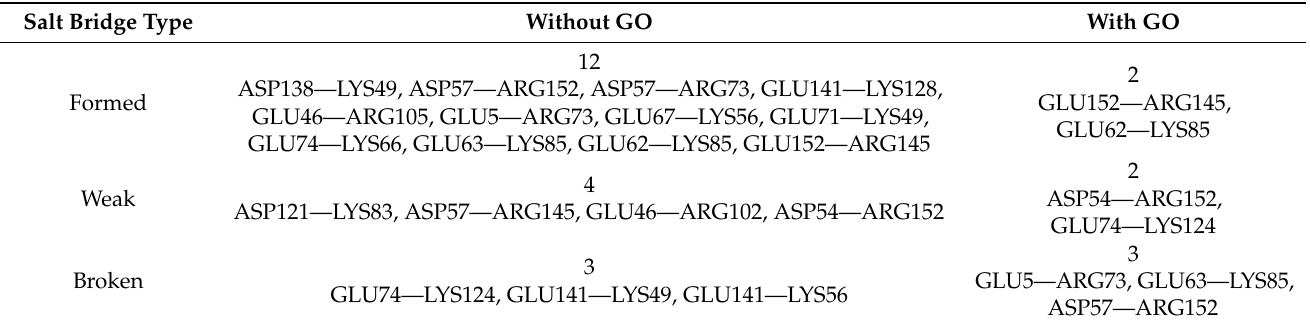
Table 1. Intermolecular salt bridges between NDPK-B and NDPK-C.